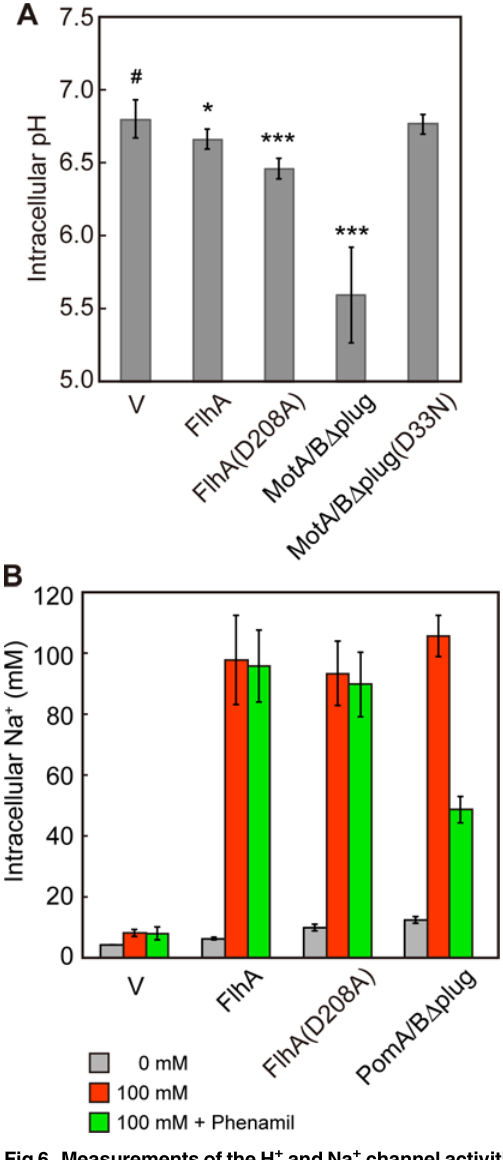
Fig 6. Measurements of the H + and Na + channel activities of FlhA. (A) Effect of overexpression of FlhA on intracellular pH change. Intracellular pH was measured with pHluorin at external pH 5.5. The BL21(DE3) strain harbouring pYC17 (pHluorin) was transformed with pBAD24 (Vector, V), pNH319 (FlhA), pYC109 (MotAB Δ plug) or pYC112 (MotAB(D33N) Δ plug). Vertical bars indicate standard deviations of six independent biological replicates. The data that exhibited a statistically significant intracellular change compared with the vector control (#) are highlighted with an asterisk ( *** , P < 0.001; * , P < 0.05). (B) Effect of overexpression of FlhA on intracellular Na + concentration. Intracellular Na + concentration was measured with CoroNa Green in the presence and absence of 100 mM NaCl with or without 200 μ M phenamil at an external pH of 7.0. The BL21(DE3) strain was transformed with pBAD24 (Vector, V), pNH319 (FlhA), pNH319(D208A) (FlhA(D208A)) or pBAD-Pom Δ plug (PomAB Δ plug). For each transformants, 200 cells were measured. Vertical bars indicate standard